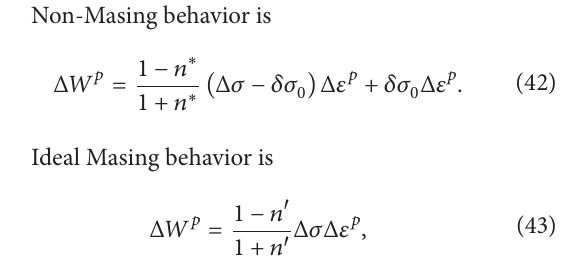
The plastic portion of strain is the one causing the damage, while the elastic portion associated with the tensile stress facilitates the crack growth [12]. This theory can be applied to Masing and non-Masing materials [246] (Figure 5) and, in both cases, a master curve can be drawn (translating loop along its linear response portion, for the non-Masing